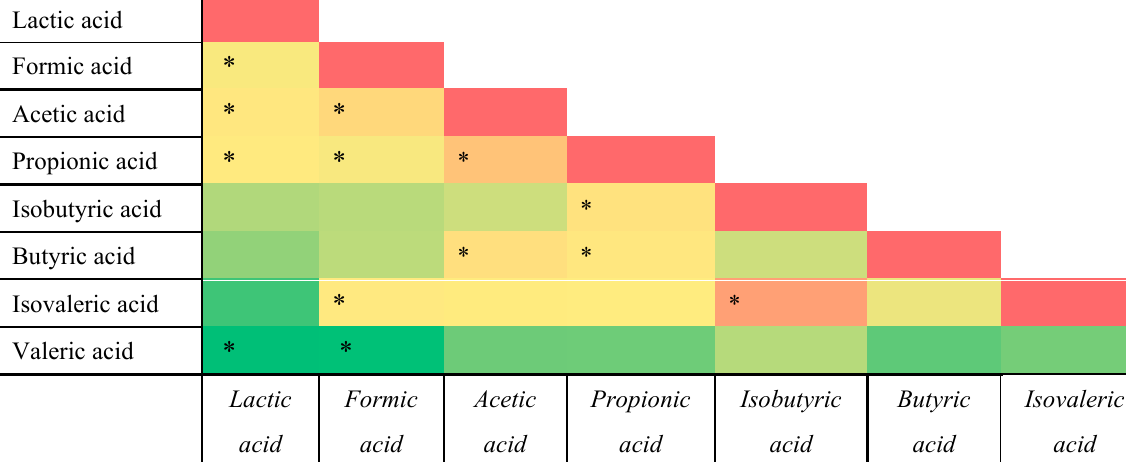
Figure 5. Pearson’s heatmap representing the correlation between the activity of fecal enzymes and concentrations of fatty acids. Green represents negative correlation, whereas orange-red represents positive correlation. *: ( p < 0.05).